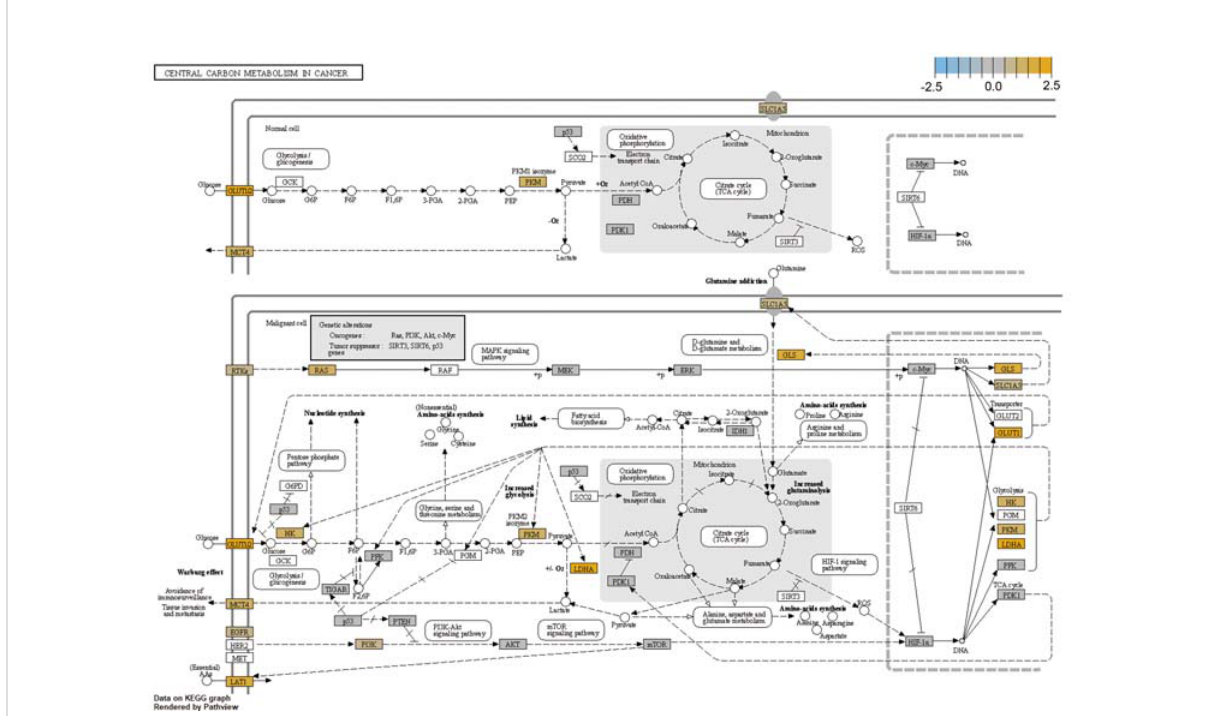
FIGURE 5 Analysis of altered gene in HSCC in cancer carbon metabolism pathways.For the cancer carbon metabolism KEGG pathway, genes within the panel were mapped to pathways, and differential expression information was overlaid on protein-based KEGG pathway